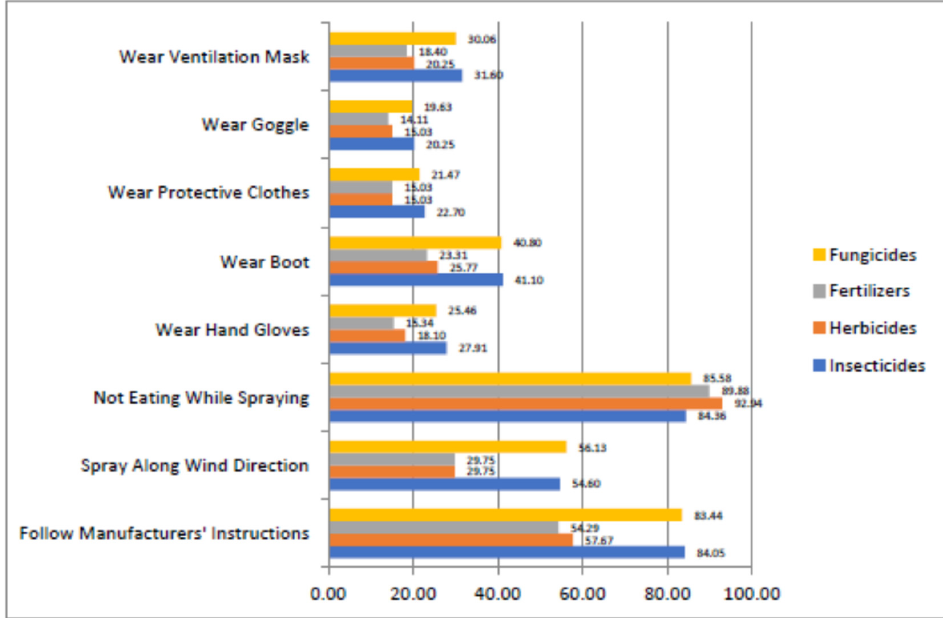
Figure 2. Cocoa farmers’ compliance with selected safety procedures when using agrochemicals.